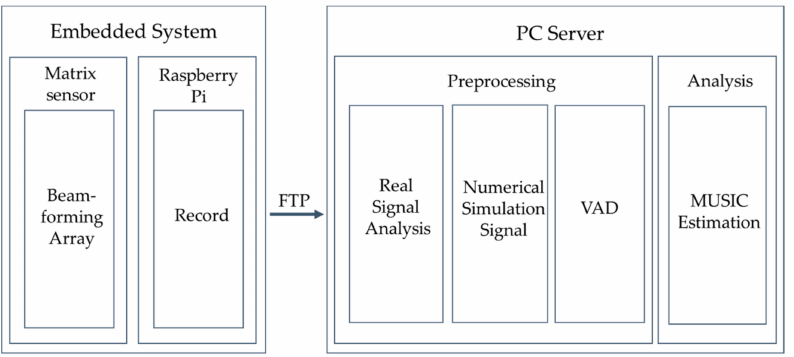
Figure 1. The measurement system setup and numerical analysis process.